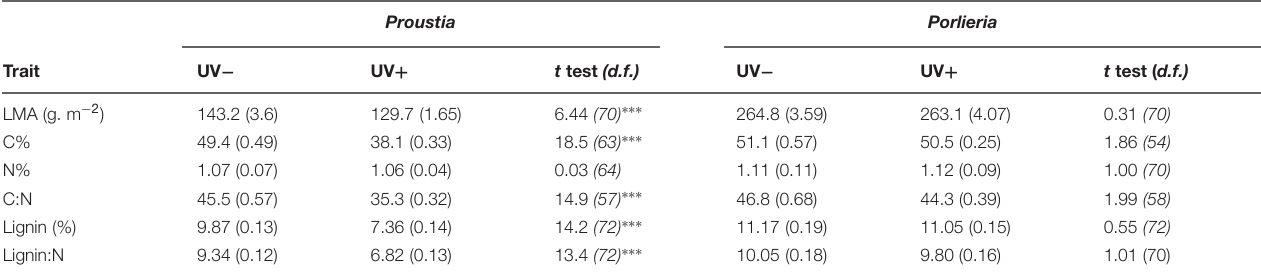
TABLE 1 | Comparisons of leaf litter traits between Proustia and Porlieria following 5 months of photodecomposition in the field. Proustia Porlieria